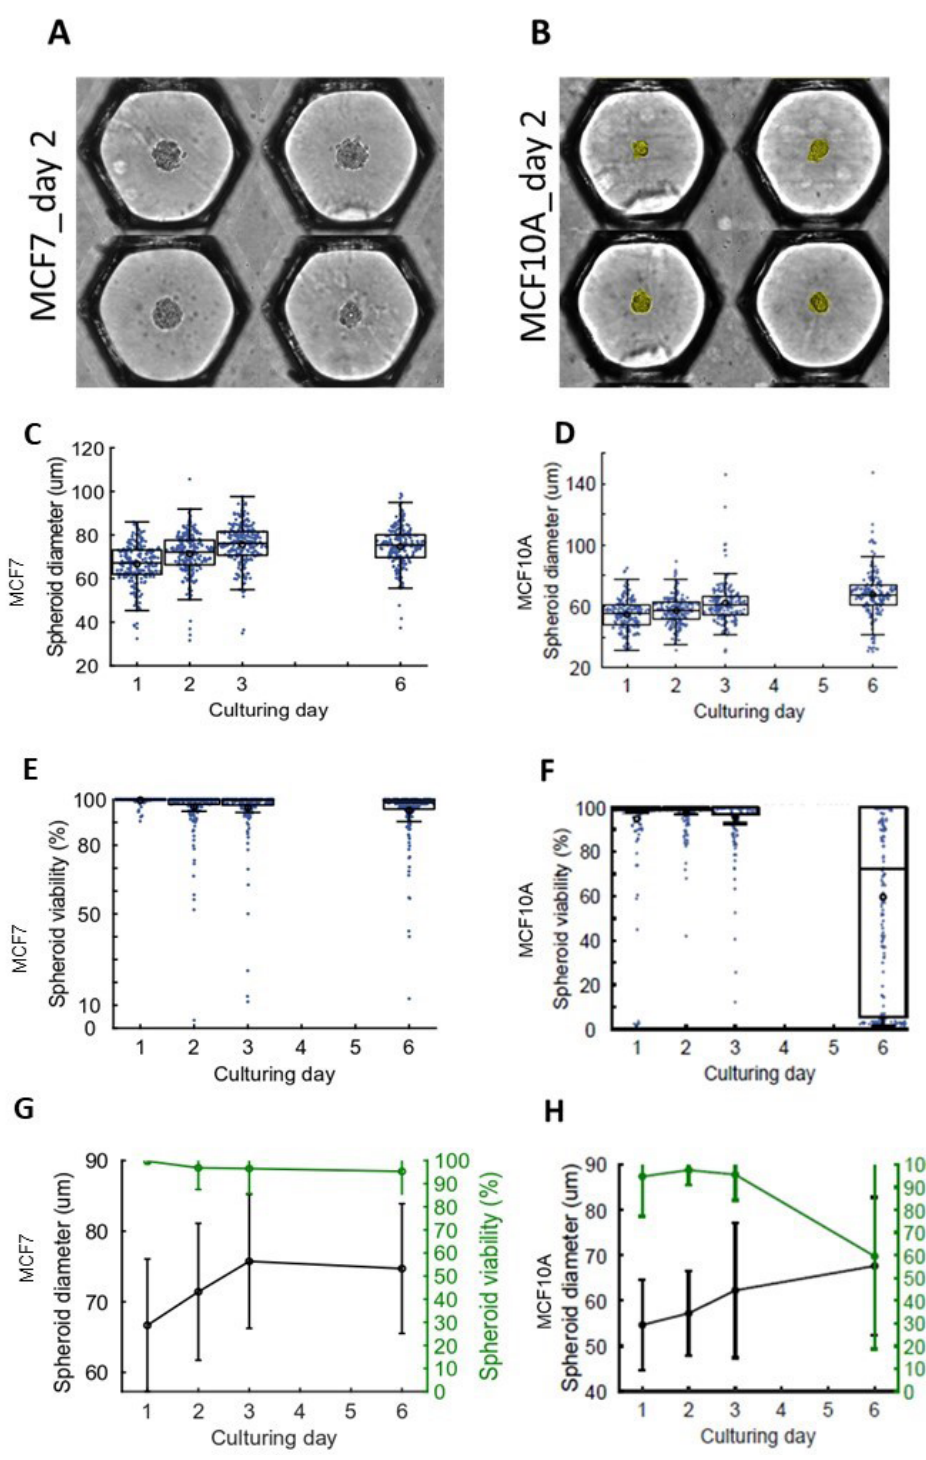
Figure 2. The 3D mammary breast cell lines LumB tumor MCF7 and epithelial MCF10A cells. (A) MCF7; and (B) MCF10A cells sediment into the anchoring traps in medium droplets and aggregate into a spheroid within 48 h. The yellow coloring shows the segmentation occurring during the analysis of the spheroid. Anchoring traps are shown side-to-side after image reconstruction for image analysis. Box dot plot showing diameter of (C) MCF7 and (D) MCF10A spheroids over time. Box dot plot of the viability of (E) MCF7 and (F) MCF10A over time. Comparison of the diameter versus viability changes over time for (G) MCF7 and (H)